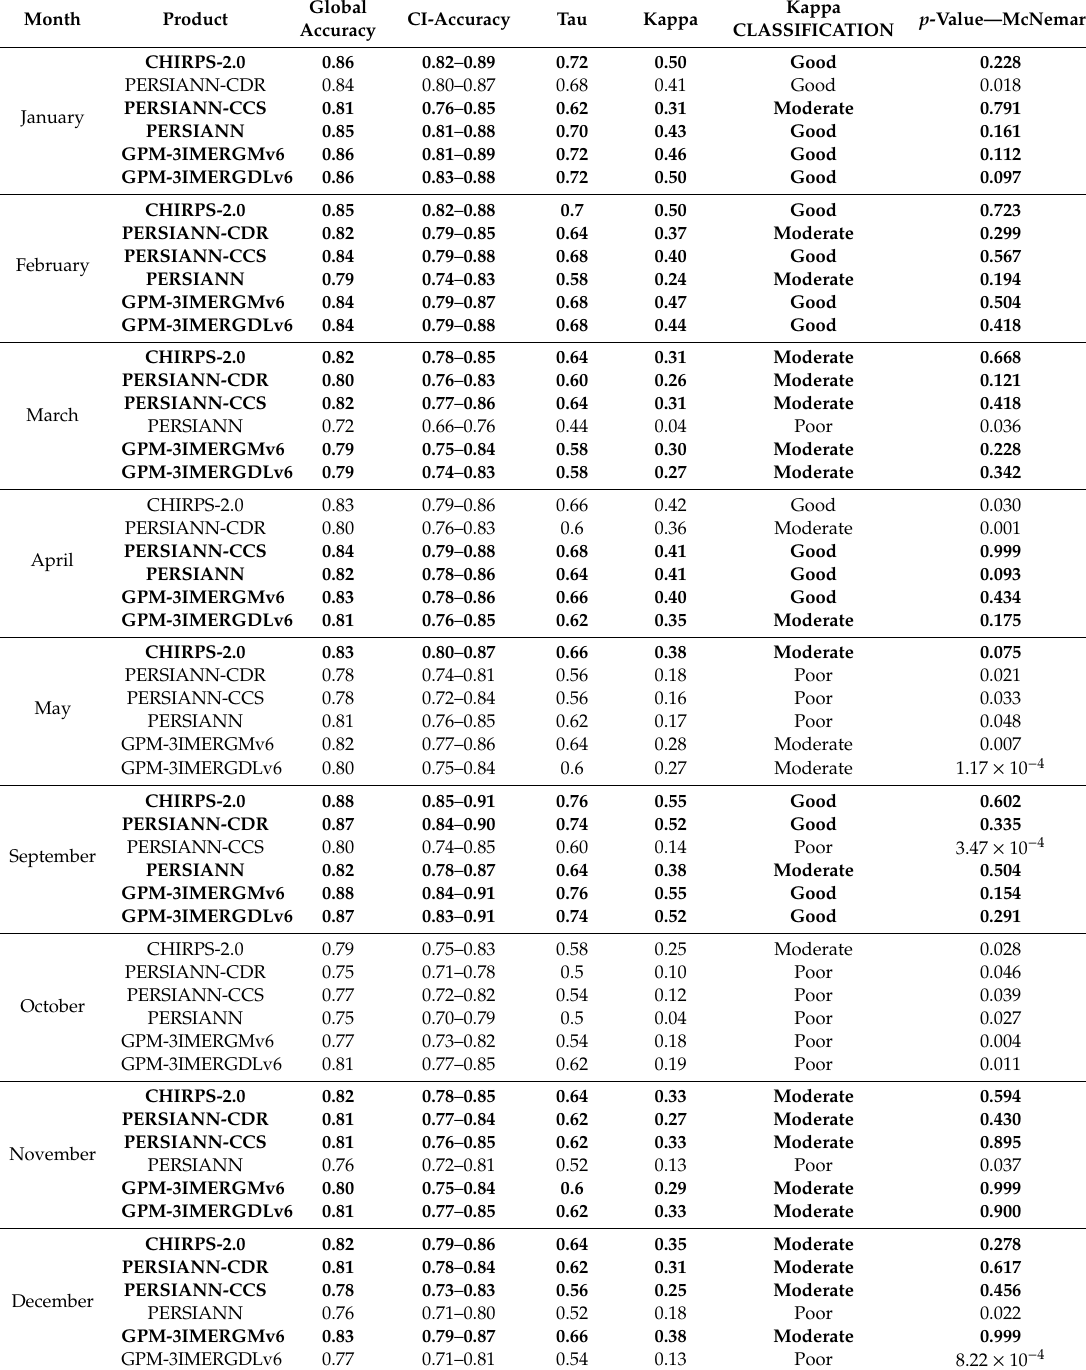
Table 5. Validation of drought estimations based on remote sensing data using the simplified SPI